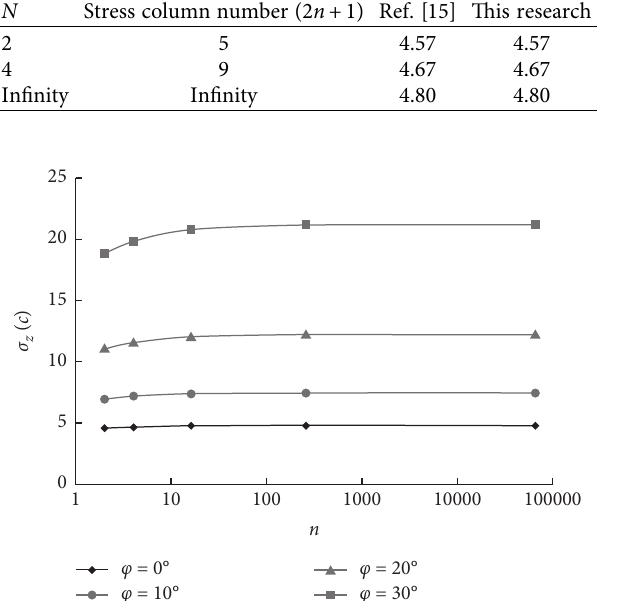
Table 2: Relative errors of the lower-bound solution with variant z / c ). stress columns.